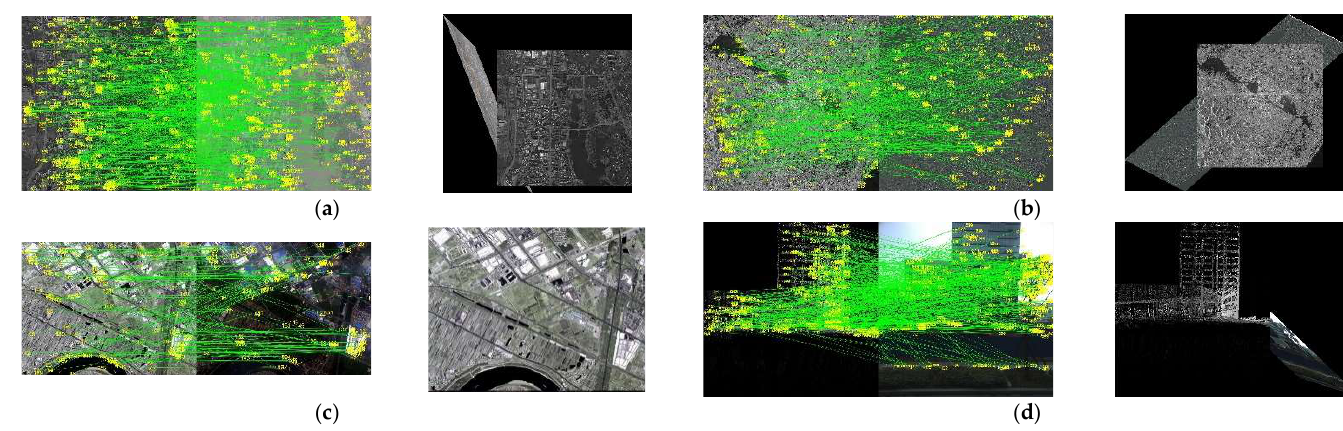
Figure 6 . Keypoint matching and SIFT-based automatic registration results of four multimodal remote sensing datasets: ( a ) Mid-infrared image and visible orthomosaic image; ( b ) Terra SAR image and optical image; ( c ) Worldview-3 near infrared image and multispectral image; ( d ) Monolithic cloud point depth image and visible image.